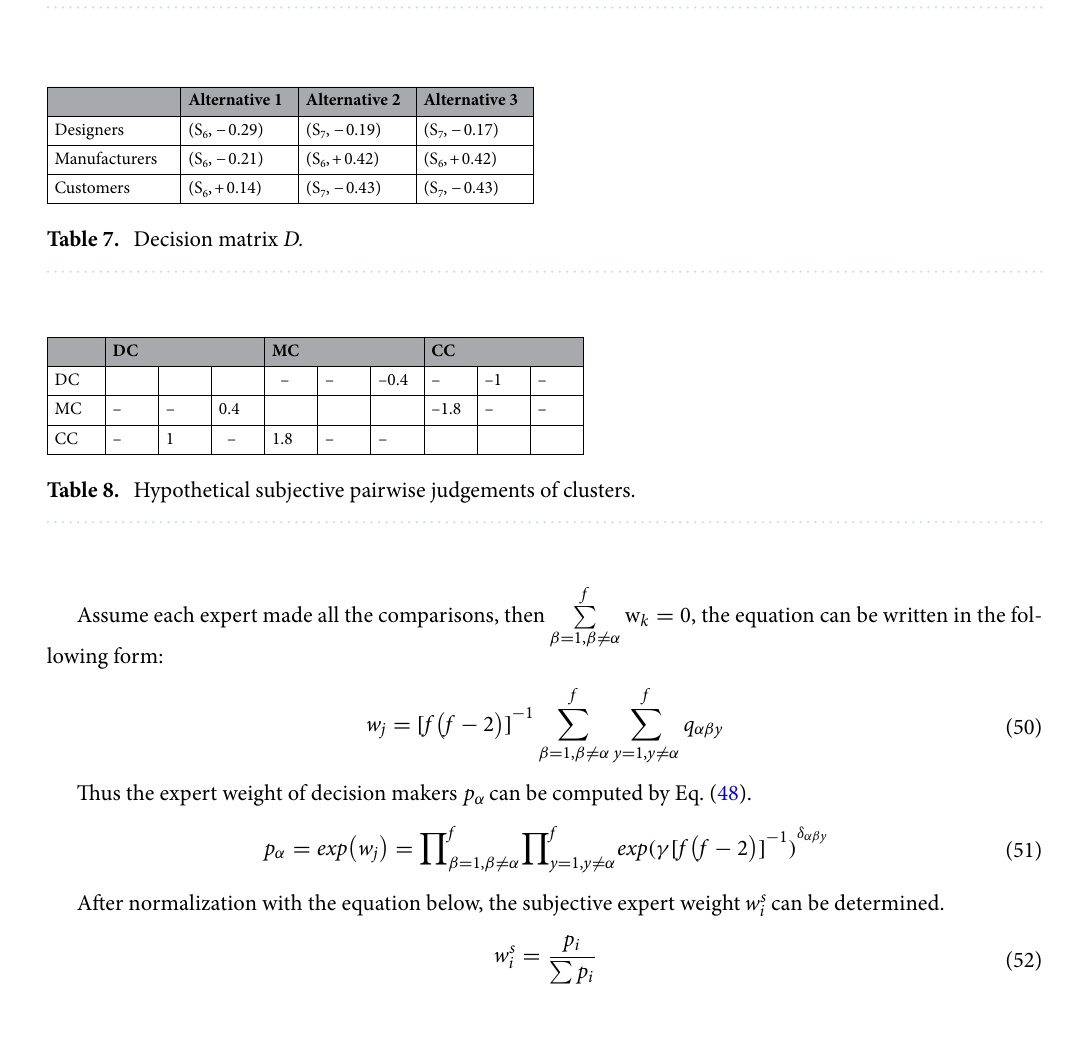
Table 6. Weight of experts in the designer, manufacturer and customer clusters.